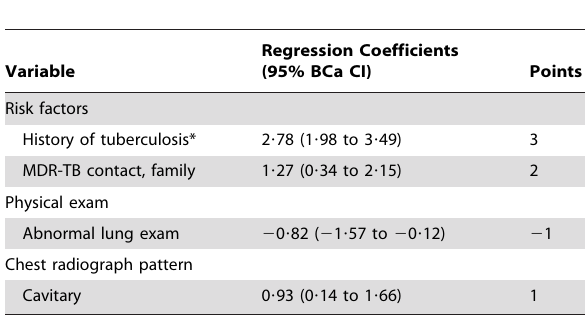
Table 2. Multidrug-Resistance Pulmonary Tuberculosis (MDR-TB) Score.